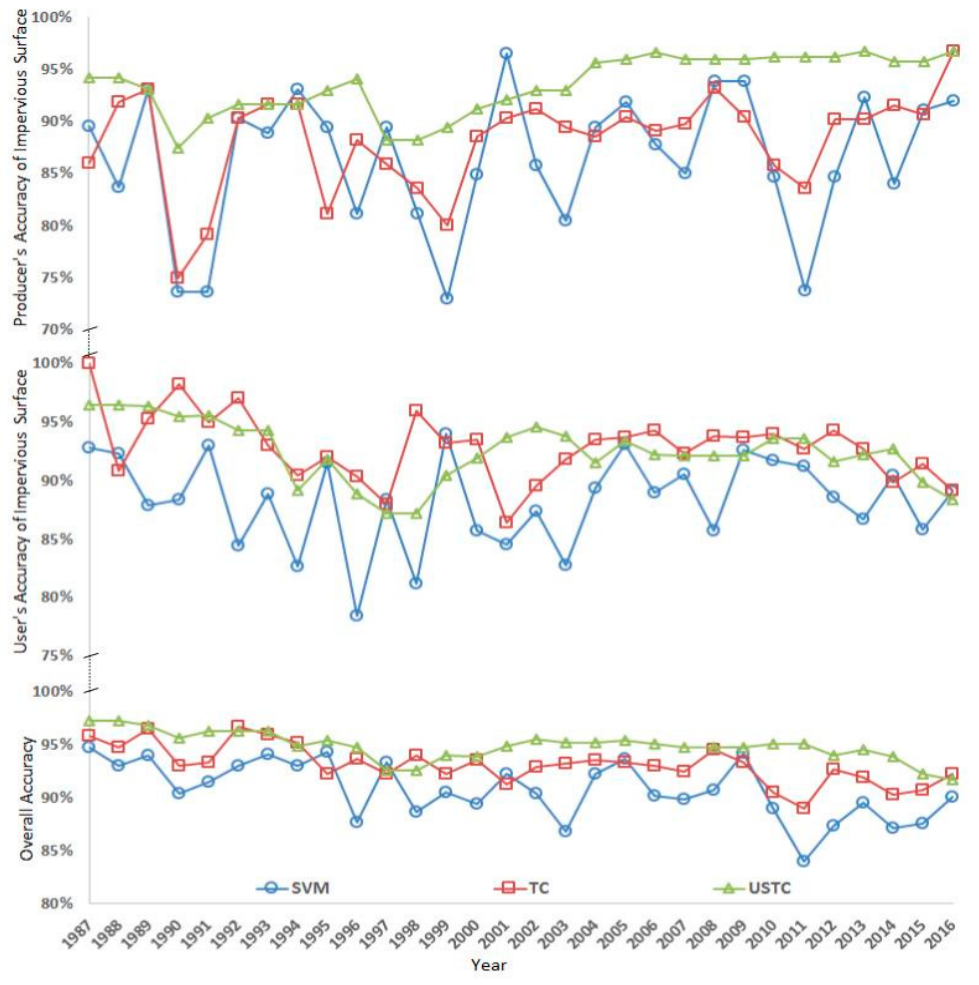
Figure 7. The accuracy comparison of three classification results derived by the SVM classifier, the temporal consistency (TC) model, and the USTC model, respectively.